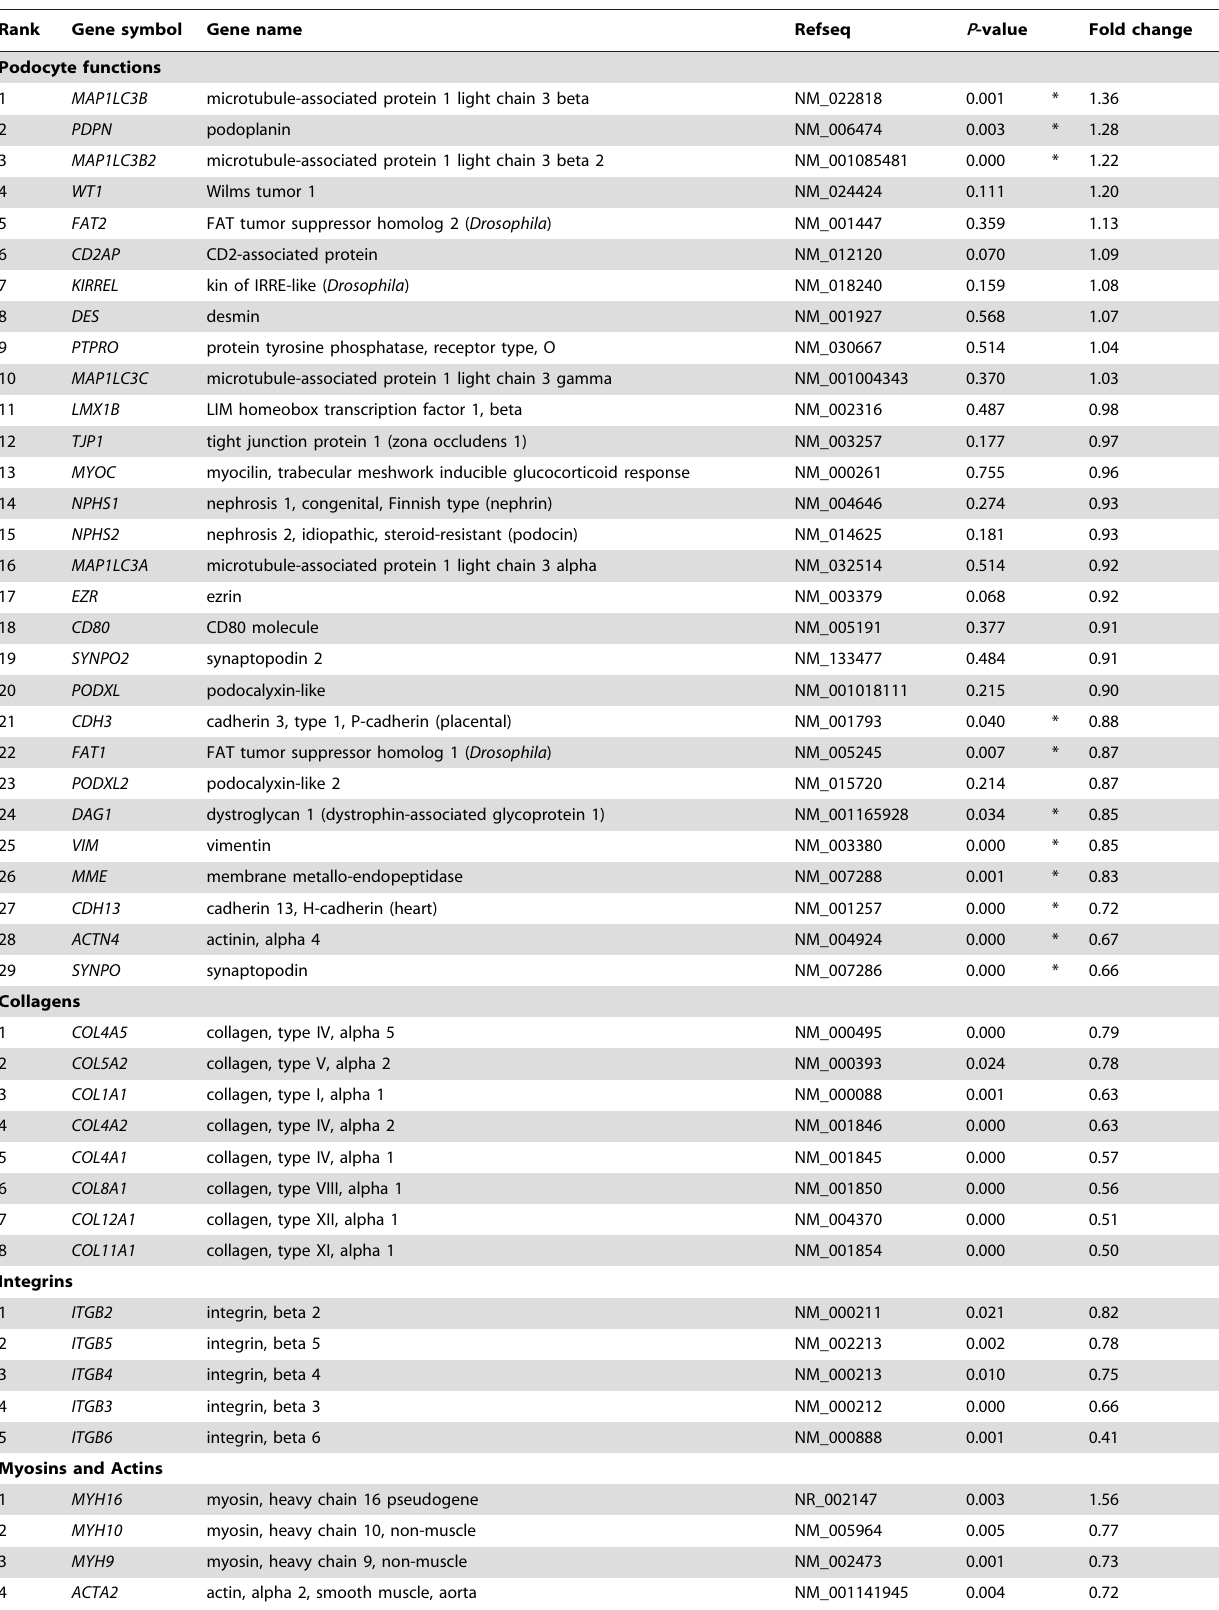
Table 1. Altered expression of podocyte function-associated genes in indoxyl sulfate-exposed human podocytes.